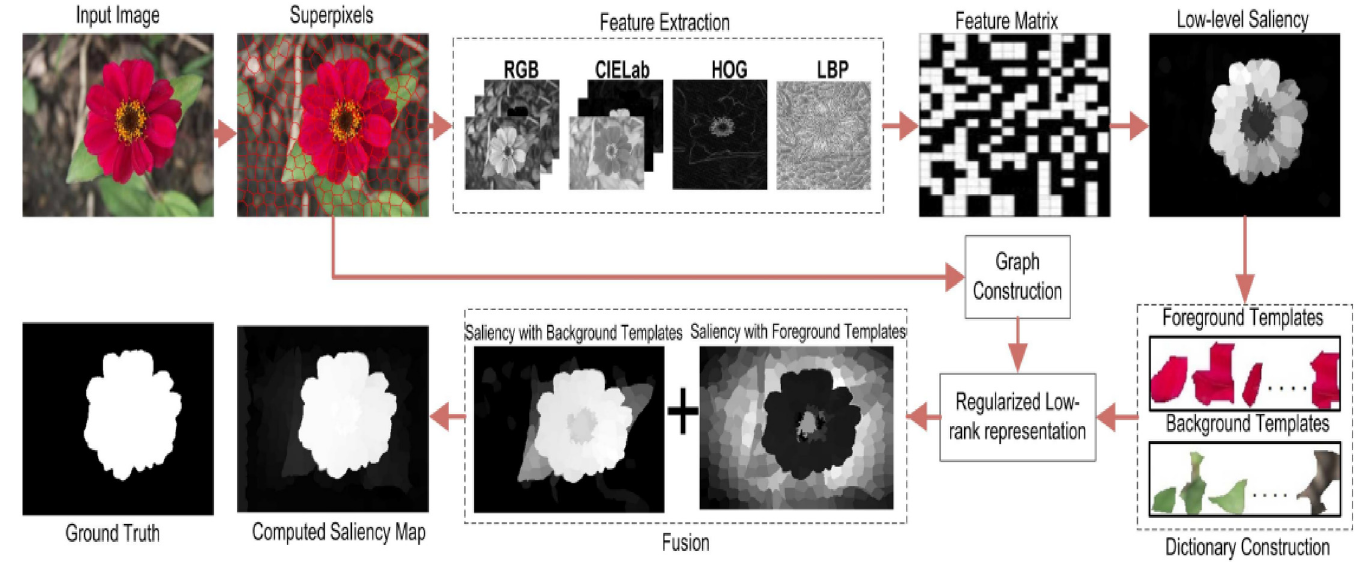
Fig 2. The pipeline of proposed SRD